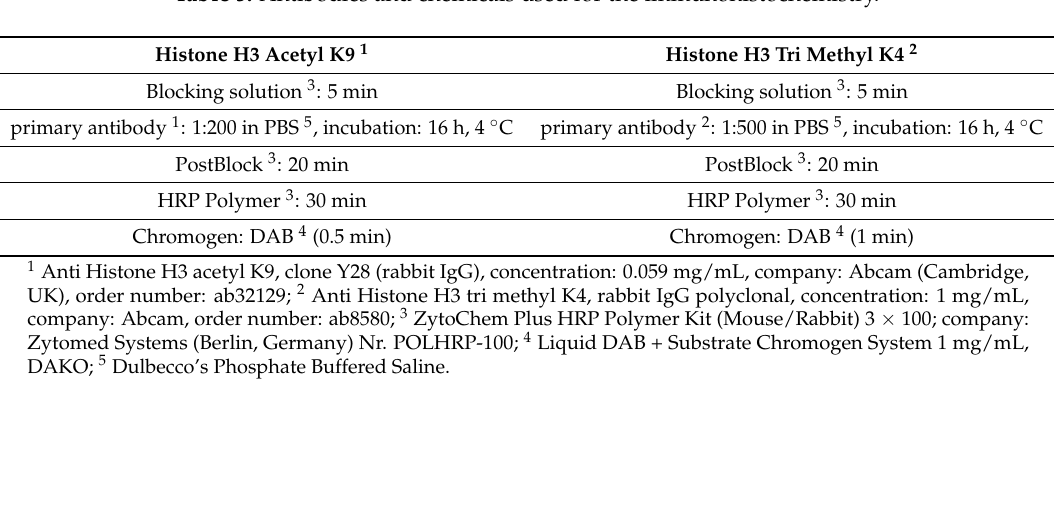
Table 5. Antibodies and chemicals used for the